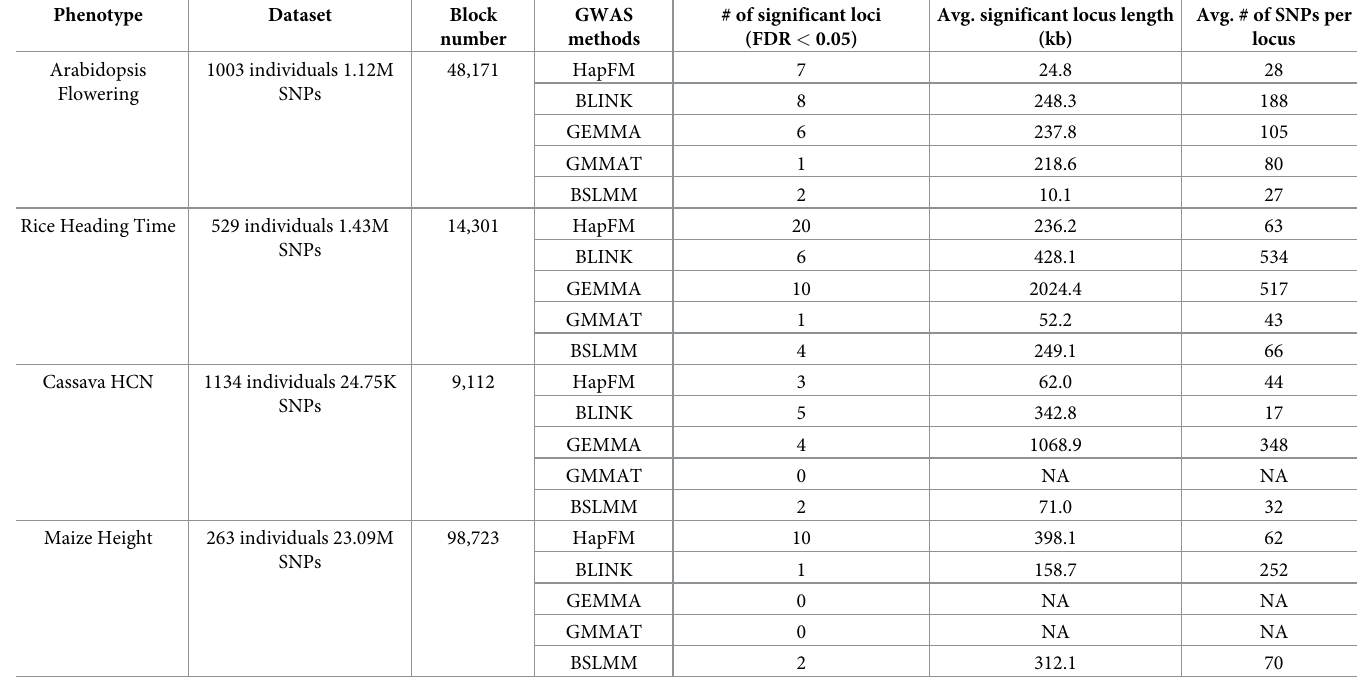
Table 1. Summary of GWAS results on the five real plant